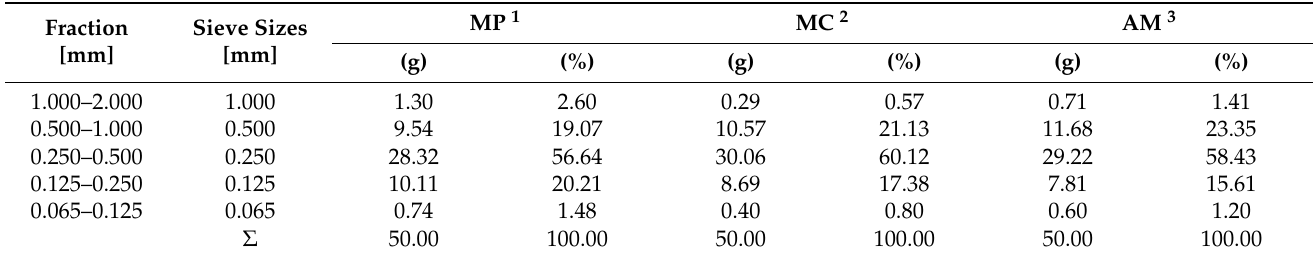
Table 6. Sieve analysis of fillers.